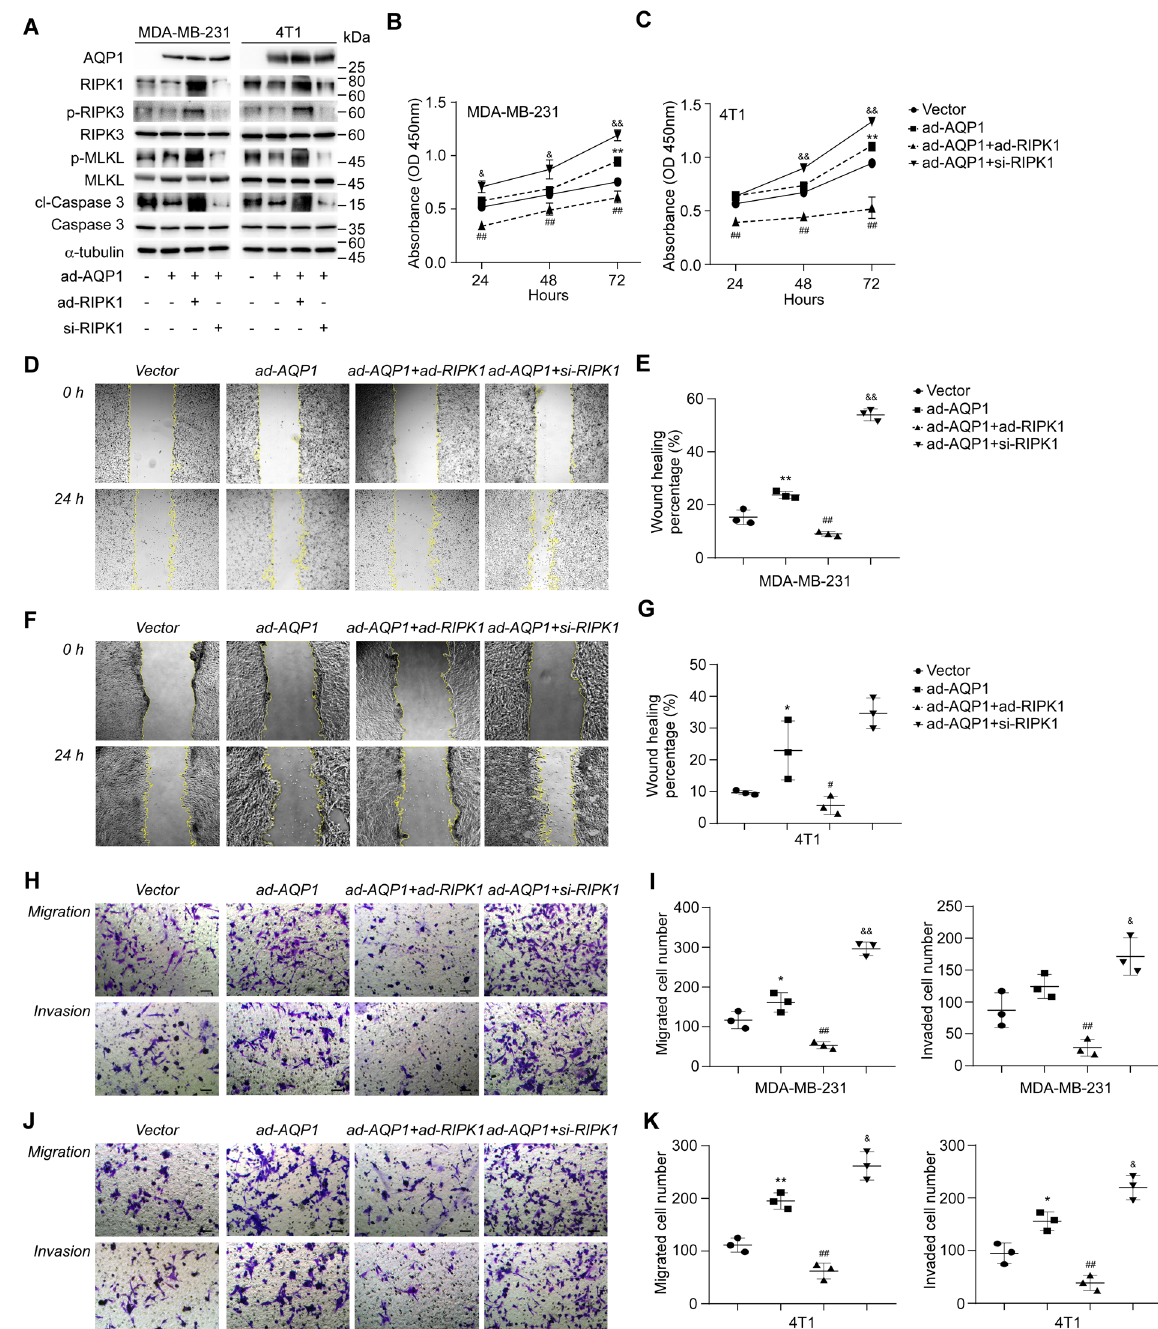
viability of indicated MDA-MB-231 cells at 24, 48, and 72 hours after cell seeding. The cell viability is displayed by the absorbance at 450nm wavelength in the CCK-8 assay ( n = 3). C Same experiment as in B , but using 4T1 cells ( n = 3). D Representative images of indicated MDA-MB-231 cells in the wound healing assay at 0 and 24hours after micropipette scratching (×100 magni fi cation). E Quanti fi cation of the wound healing percentage at 24hours after micropipette scratching in indicated MDA-MB-231 cell cultures ( n = 3). F , G Same experiment as in D and E , but using 4T1 cells ( n = 3). H Representative images of indicated MDA-MB-231 cells in the transwell migration and invasion assays (×200 magni fi cation). Scale bar : 100 μ m. I Quanti fi cation of migrated and invaded cells for indicated MDA-MB-231 cells ( n = 3). J , K Same experiment as in H and I , but using 4T1 cells ( n = 3). Abbreviations : ad-AQP1, AQP1 overexpression; ad-RIPK1, RIPK1 overexpression; si-RIPK1, RIPK1 knockdown with siRNA. Note : * p < 0.05 and ** p < 0.01 vs. empty-vector control; # p < 0.05 and ## p < 0.01 vs. ad-AQP1 group; & p < 0.05 and && p < 0.01 vs. ad-AQP1